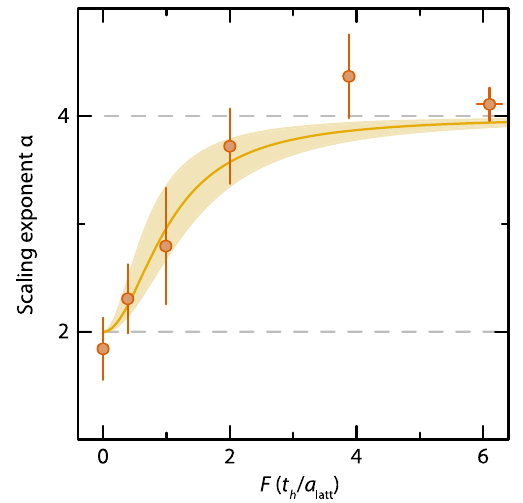
FIG. 3. Diffusive-to-subdiffusive crossover. Extracted scaling exponent α for τ ∝ λ α from data sets at different tilts (orange circles). As the tilt is increased from Fa Fa =t ≈ 6 , the relaxation of initial density waves crosses over h latt from characteristically diffusive ( α ¼ 2 ) to subdiffusive with α ≈ 4 . The shaded curve is a prediction of our hydrodynamic model, which is derived in detail in the Supplemental Material